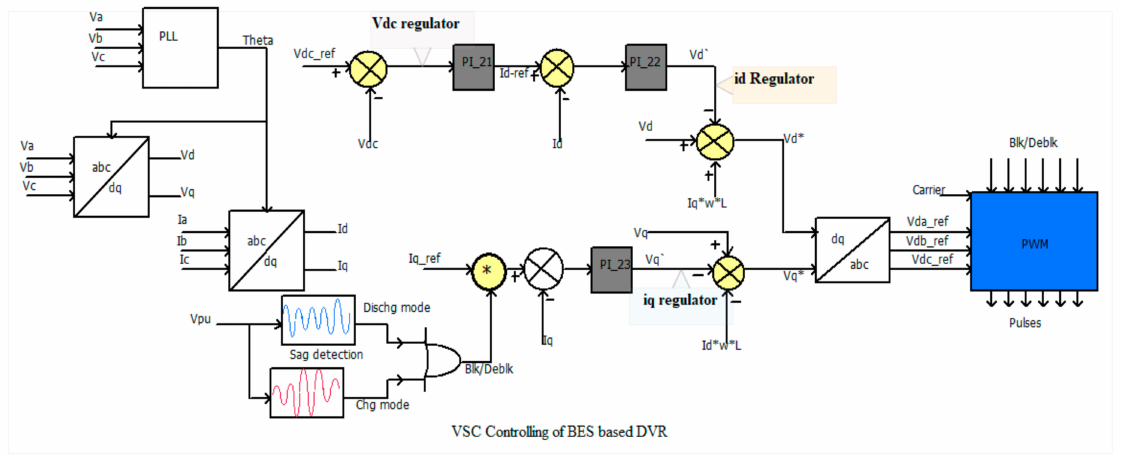
Figure 10. VSC controlling of the BES-based